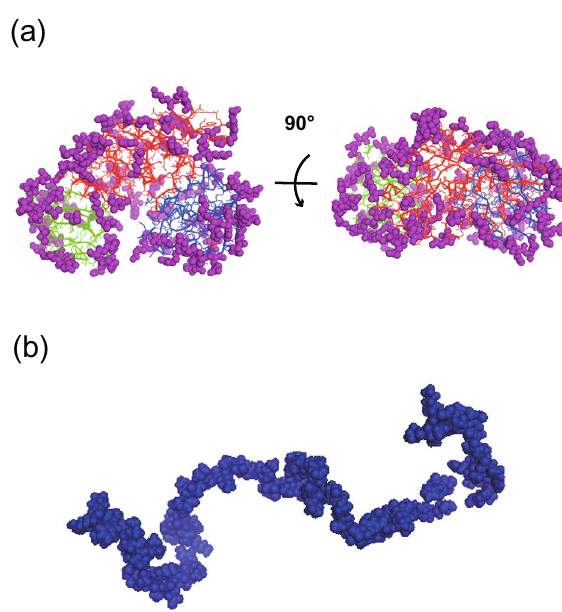
Figure 6. Schematic view of solvent-exposed amino acid residues for MurD and Hef-IDR when f* t = 0.6. (a) In the case of f* t = 0.6, the amino acid residues, which are located in solvent accessible surface area, were depicted for MurD by purple spheres. The domain 1, 2, 3 were depicted by green, red and blue sticks, respectively. (b) In the case of f* t = 0.6, the amino acid residues, which are located in solvent accessible surface area, were depicted for Hef-IDR by blue spheres. This figure is prepared by the usage of Adobe Illustrator CC 2015.2.1 (19.2.1) (https ://www.adobe .com/jp/produ cts/illus trato r.html) and PyMOL 1.8.4.0 (https ://pymol